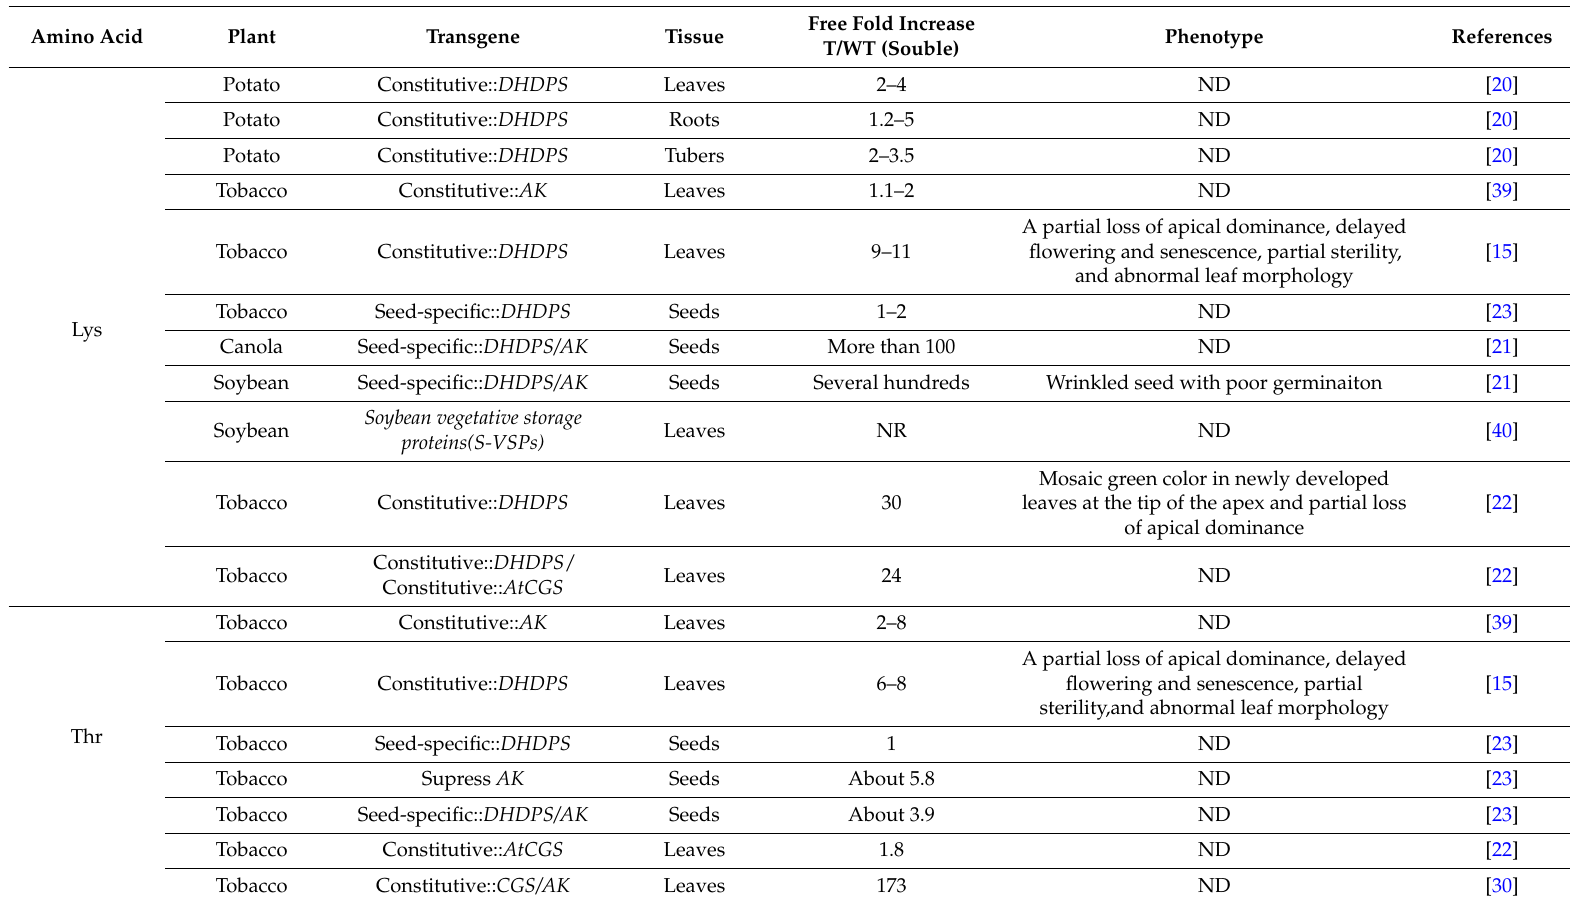
Table 1. Increase the levels of essential amino acids lysine (Lys), methionine (Met), threonine (Thr), and tryptophan (Trp) in transgenic horticultural plants. Amino